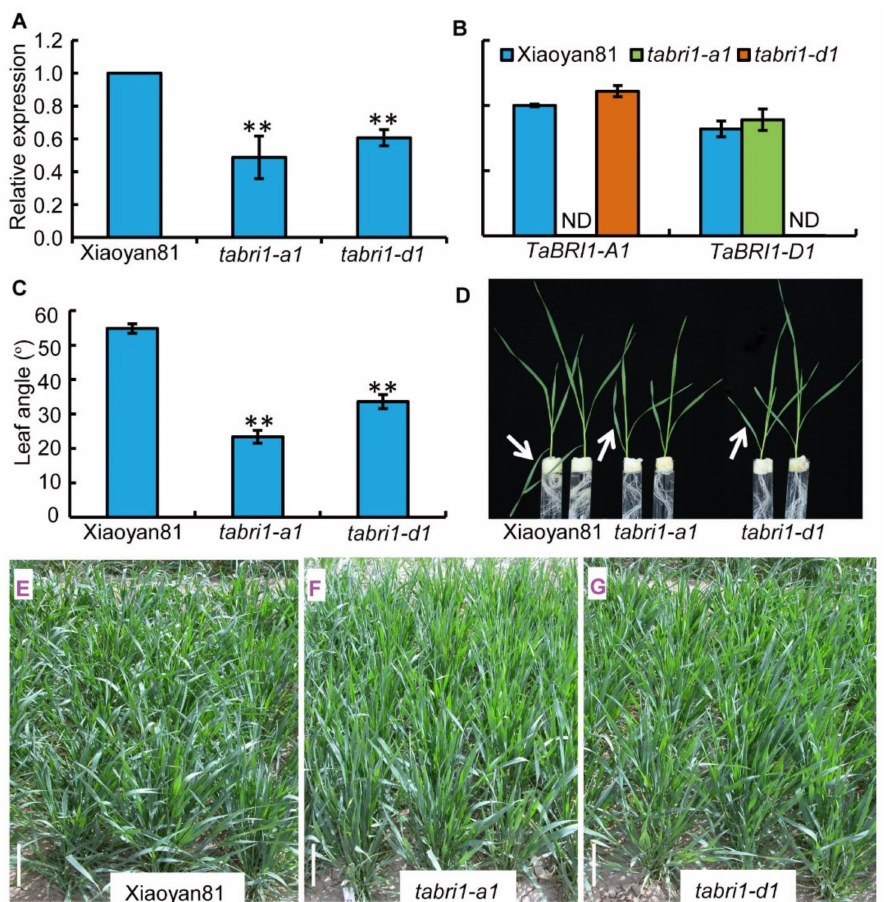
Figure 3. Angle between leaf blade and leaf sheath of wild-type (WT) Xiaoyan81 and TaBRI1 mutants at seedling stage. ( A ) Relative expression levels of total TaBRI1 genes in WT and TaBRI1 mutants at seedling stage. Each genotype had three biologic replicates, and each biologic replicate comprised a pool of five plants. ** indicates significant di ff erences between WT and TaBRI1 mutants at p < 0.01; ( B ) relative expression levels of TaBRI1-A1 and -D1 . Each genotype had three biologic replicates and each biologic replicate comprised a pool of five plants; ( C ) leaf angle in WT and TaBRI1 mutants. Each genotype had three biologic replicates, and each biologic replicate comprised fifteen plants; ( D ) Leaf morphology. The leaf of WT (left) is bent at the lamina joint indicated by the white arrow, whereas the leaves of TaBRI1-A1 (center) and TaBRI1-D1 (right) mutants are more erect; ( E – G ) morphology of WT, TaBRI1-A1 and TaBRI1-D1 mutants in the field at the seedling stage. Bars = 10